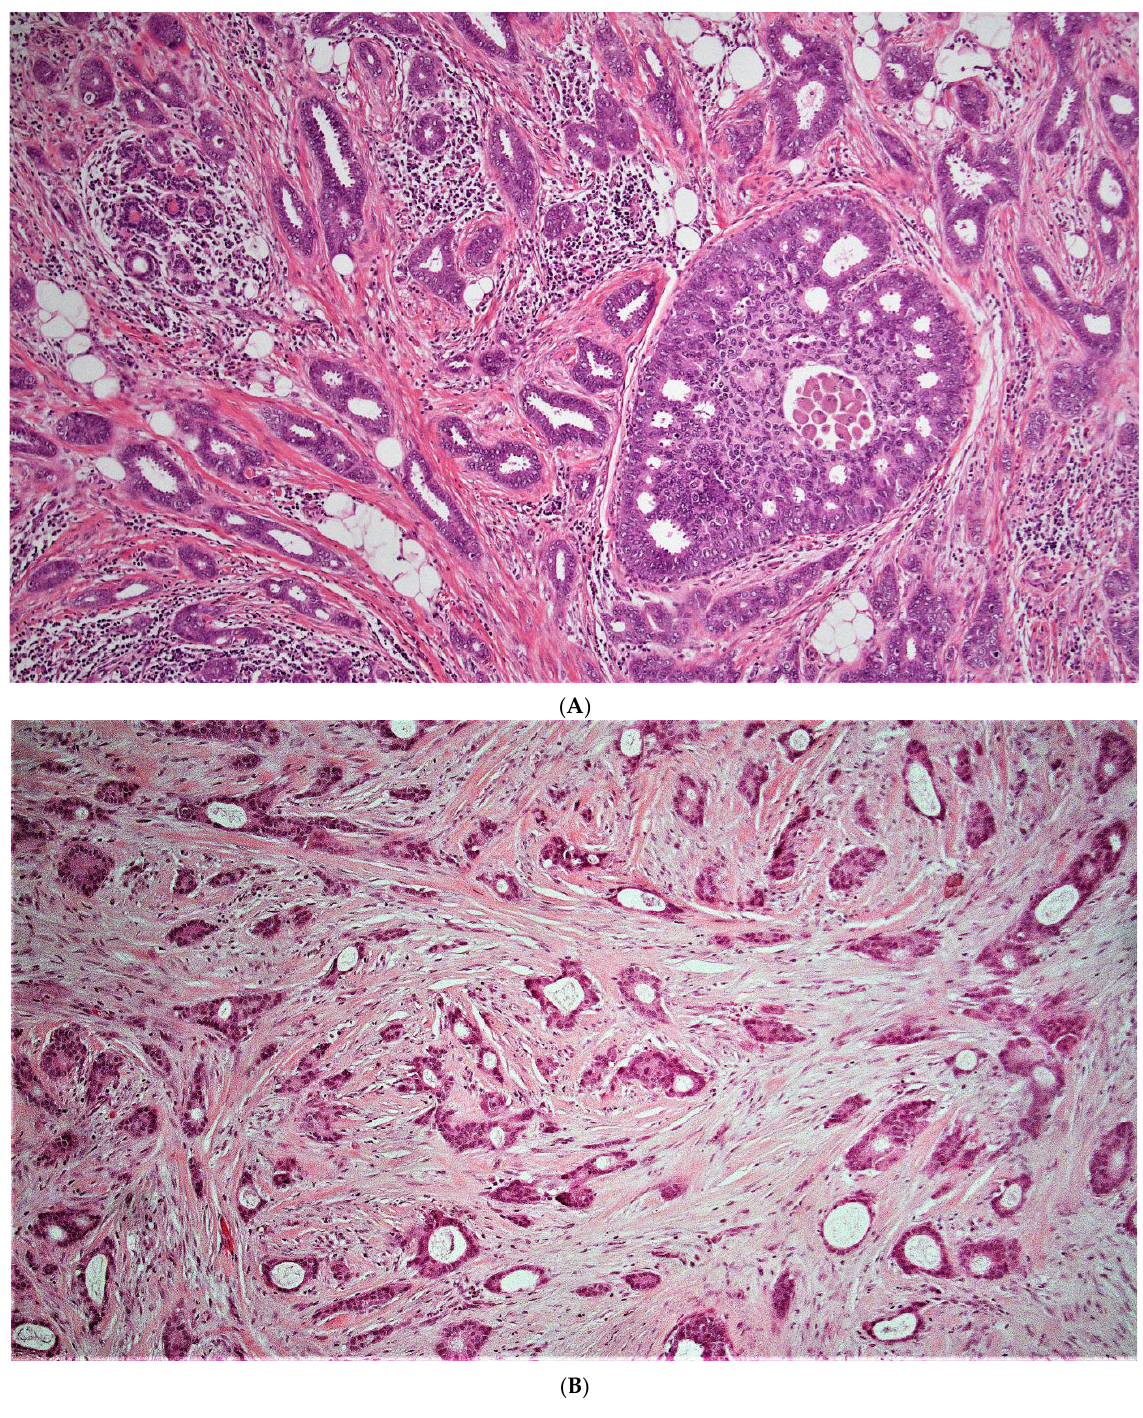
Figure 3. ( A , B ) (10×): Two examples of very low risk aMMs patients considered to be higher risk by ODX ( A ) ([supplemental Table S1 — case # 4]; ( B ) [supplemental Table S1 — case # 6]). Note the low grade histologic qualities in both patients. Note the background inflammation and DCIS in ( A ), both of which have been suggested as potential artifacts associated with an elevated ODX recurrence score [95]. Note the somewhat cellular stroma in ( B ), which has also been associated with an elevated ODX recurrence score [95]. Neither of these patients recurred (follow-up of 98 and 137 months,